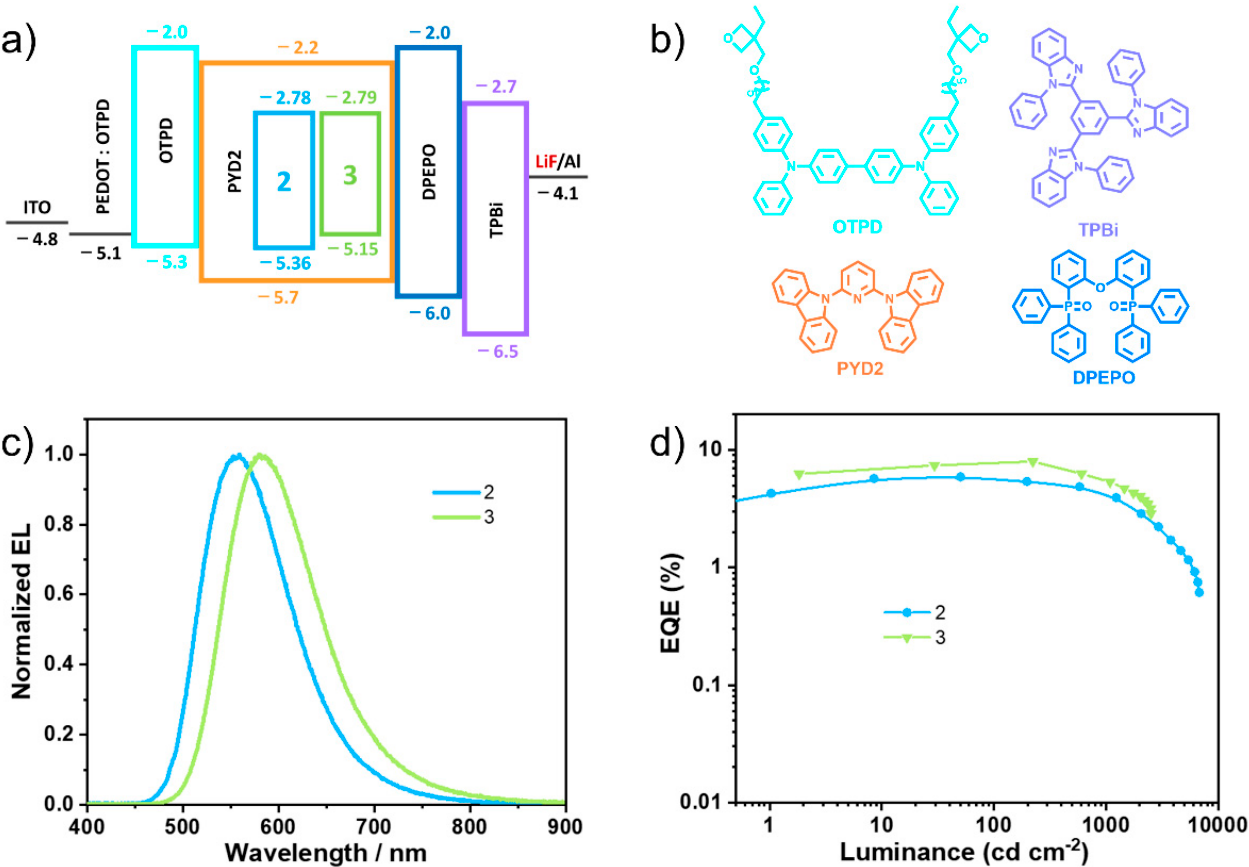
Figure 5. ( a ) The device configuration and ( b ) chemical structures of the organic materials used in the devices; ( c ) electrolu- minescence (EL) spectra of the optimized devices; ( d ) plots of external quantum efficiency versus